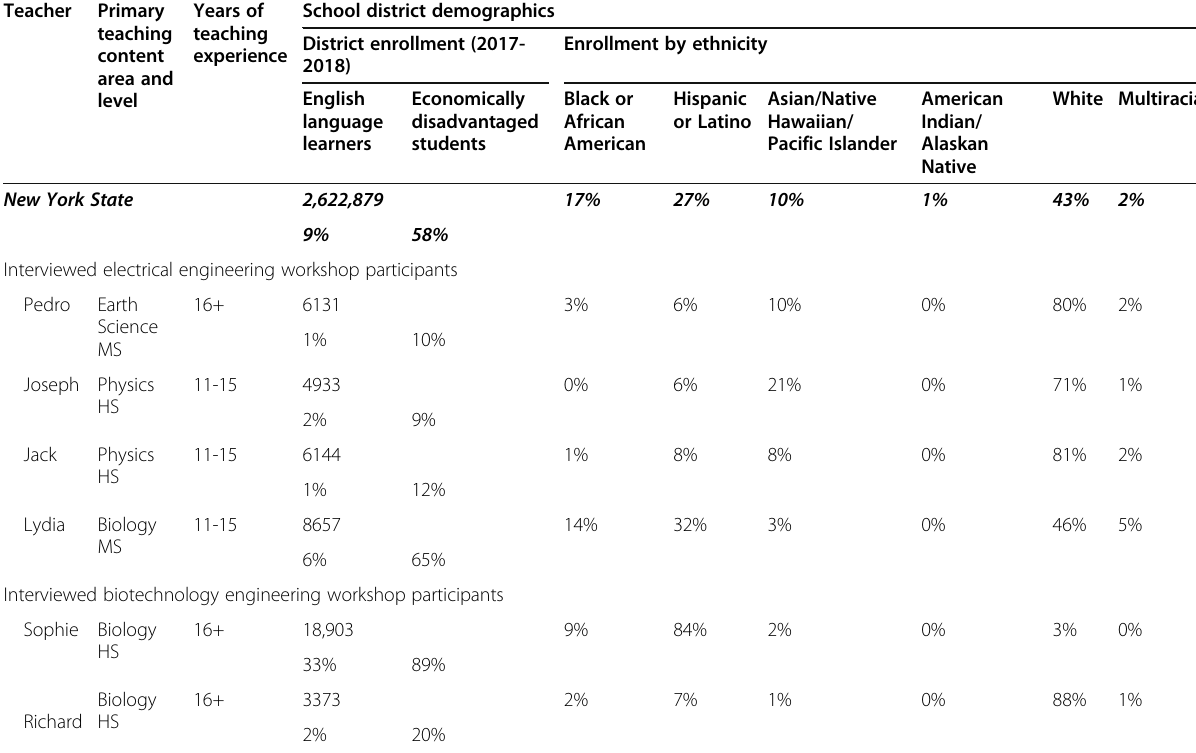
Table 1 Teacher interview participants (NYSED 2018)